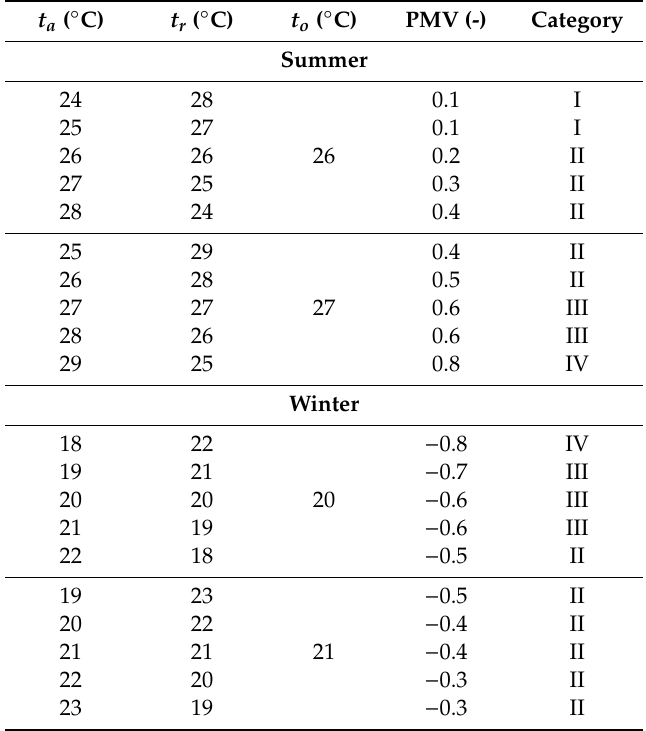
Table 3. E ff ect of the operative temperature on the PMV evaluation. M = 1.2 met, v a = 0.10 m / s, R.H. = 40% in winter (60% in summer), I cl,r = 1.0 clo in winter (0.5 clo in